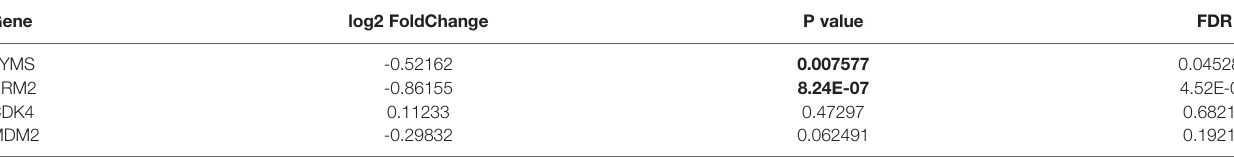
TABLE 4 | High-throughput RNA sequencing of key gene expression in target therapy of liposarcoma. Gene log2 FoldChange P value FDR